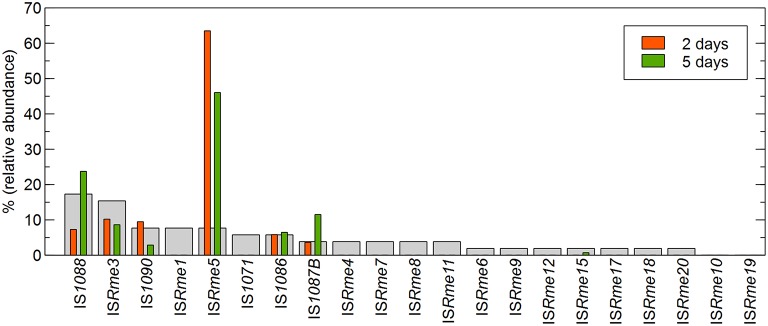
Correlation between the copy number and transposition of IS elements in the cnrYX locus identified in zinc-resistant AE126 derivatives. Red and green bars represent the relative abundance of a specific IS element identified in the pool of IS-mediated zinc-resistant AE126 derivatives isolated after 2 and 5 days of incubation, respectively. Light gray bars represent the relative abundance of a specific IS element in the genome of C. metallidurans AE126.